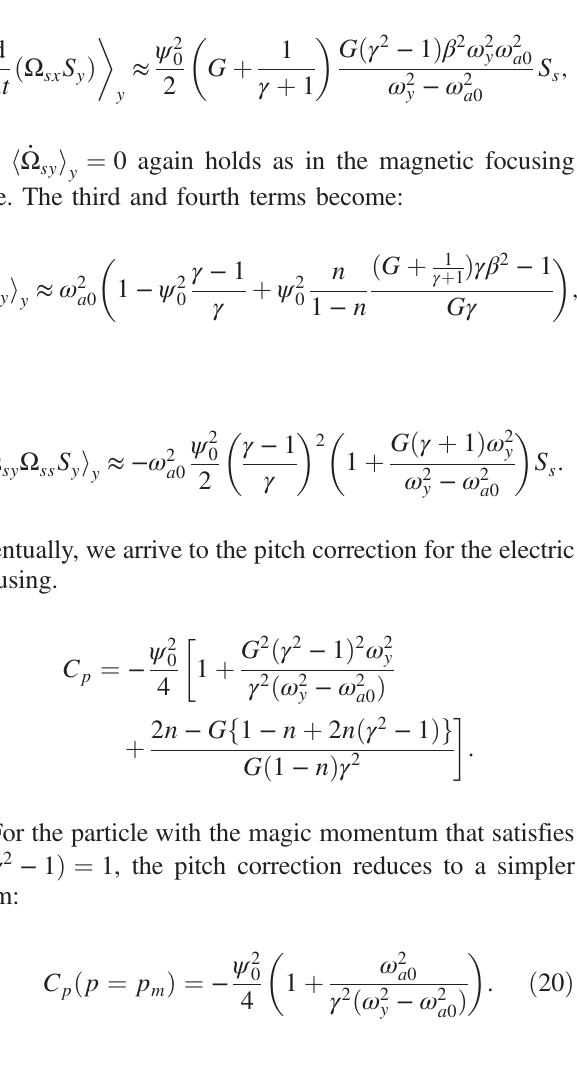
TABLE II. Analytical approximations of corrections to the spin precession frequency in the magnetic and electric weak focusing storage